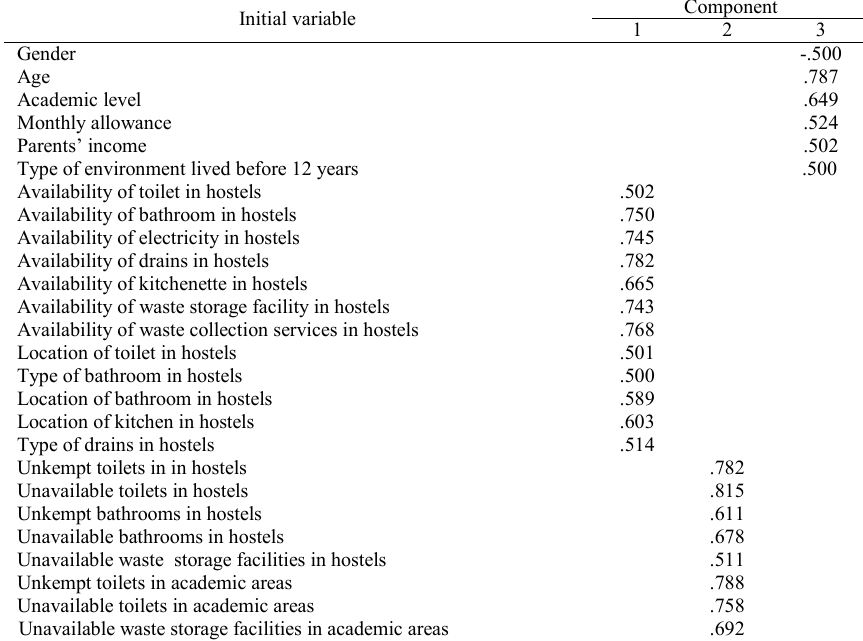
Table 2: Rotated component matrix